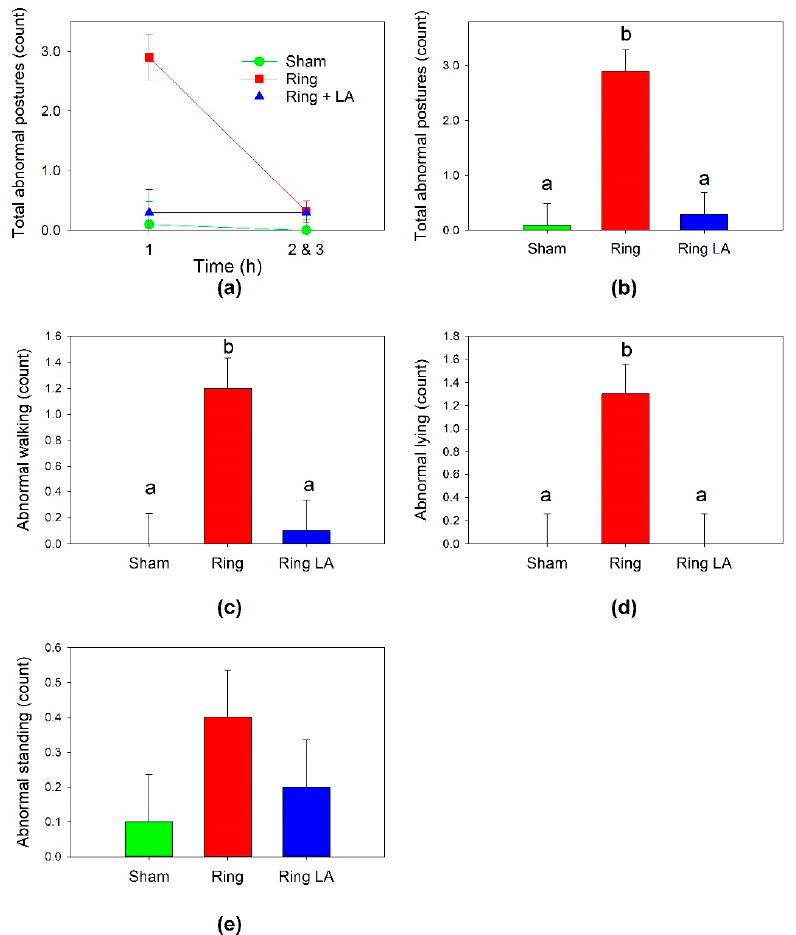
Figure 2. Abnormal postural behaviors in lambs after tail docking with (Ring LA) or without (Ring) anesthetic, or sham treatment (Sham). Individual graphs show lambs’ ( a ) total abnormal postures in hour 1, and hours 2 and 3, ( b ) total abnormal postures in the first hour, ( c ) abnormal walking in the first hour, ( d ) abnormal lying in the first hour ( e ) abnormal standing in the first hour. Data points with a matching lowercase letter indicate no significant differences between those data points.